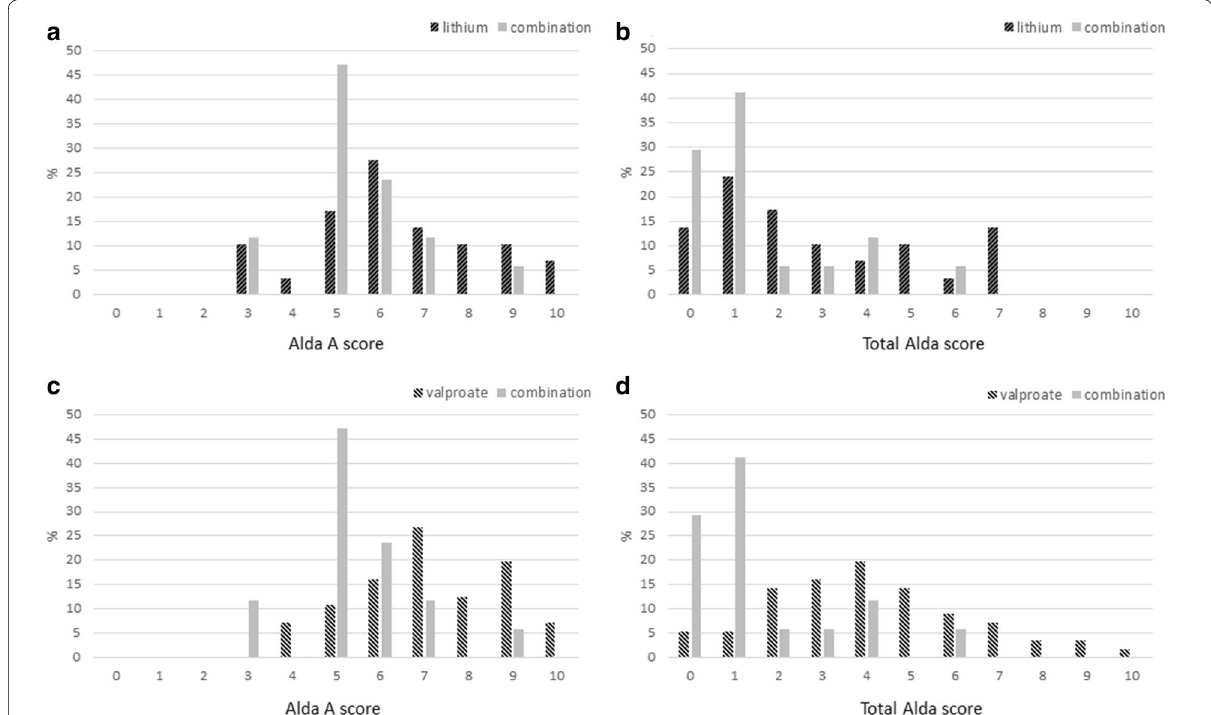
Fig. 1 Distribution of Alda scale scores in the monotherapy and combination groups. The x‑axis illustrates the scores of the Alda and the y‑axis illustrates percentage of patients in each group. a Alda A scores of the lithium users. b Total Alda scores of lithium users. c Alda A scores of valproate users. d Total Alda scores of valproate